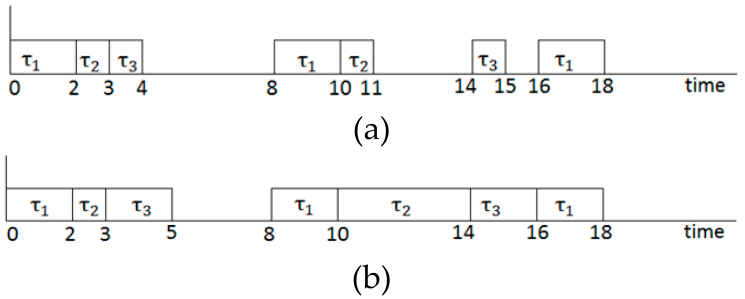
Figure 2. Comparison of the scheduled task set. ( a ) Scheduling result by original earliest deadline first (EDF), ( b ) scheduling result by the proposed approach.